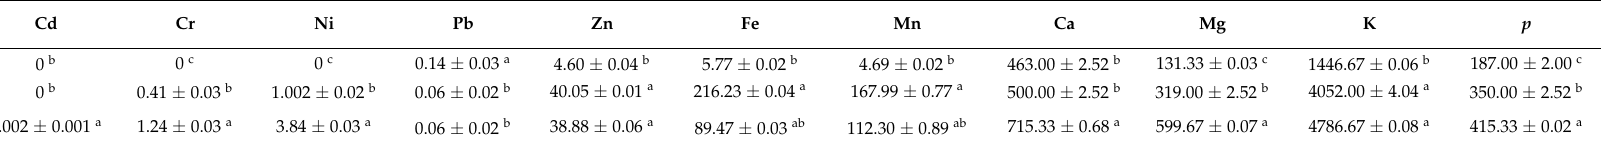
Table 3. The content of micro and macroelements of wheat flour and hemp